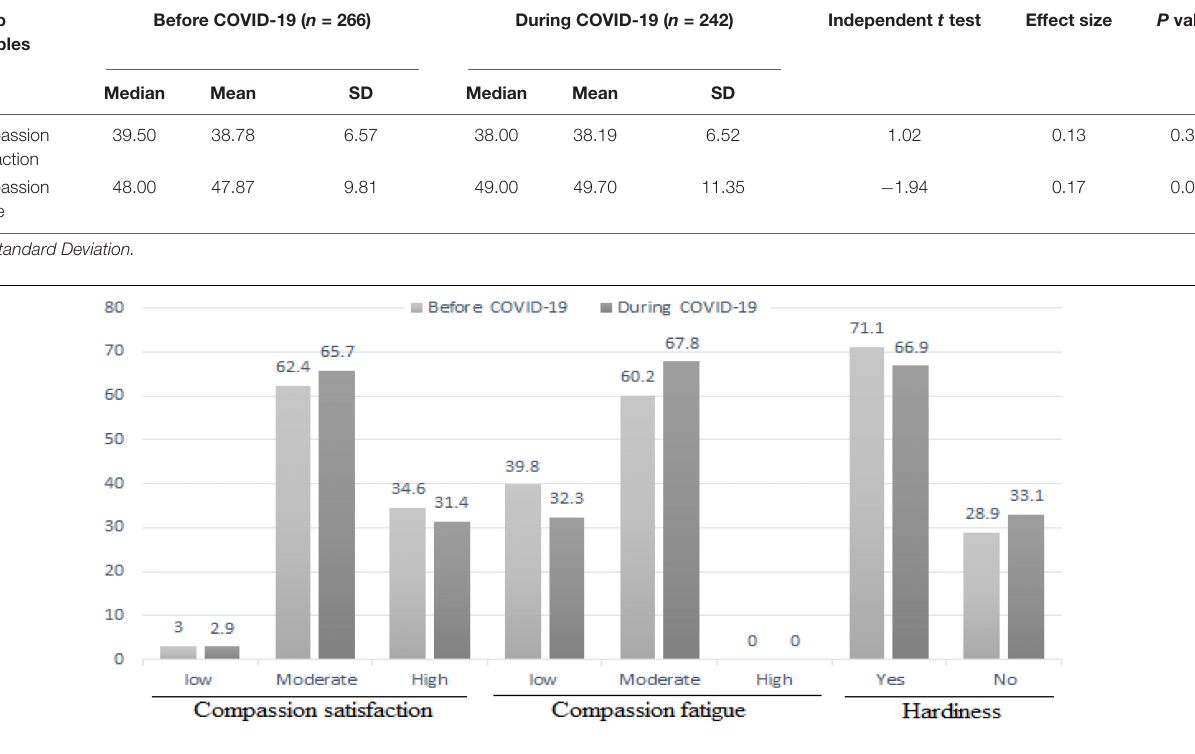
FIGURE 1 | The comparison of the level of professional quality of life score and hardiness before the COVID-19 and during the COVID-19. TABLE 3 | Comparison of the level of hardiness among the nurses before the COVID-19 and during the COVID-19. Group Before COVID-19 ( n = Variables